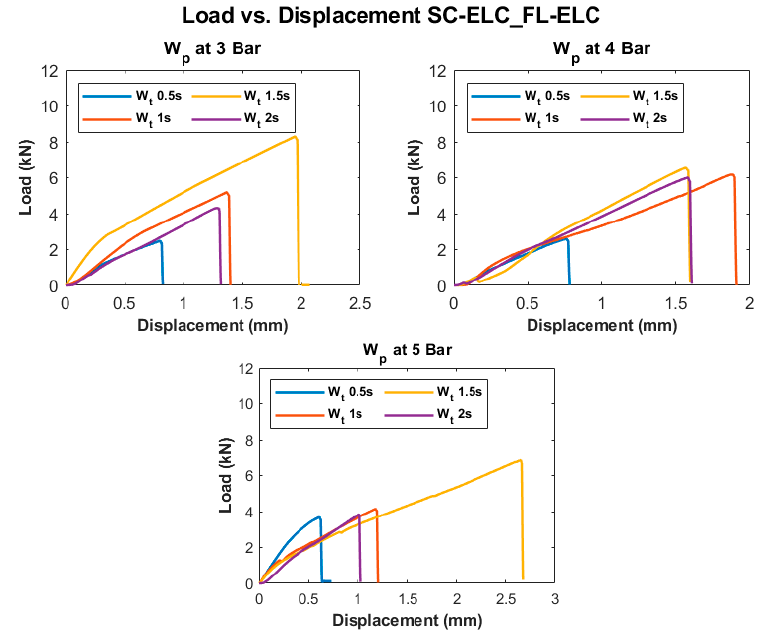
Figure 11. Load vs. Displacement curves of SC-ELC_FL-ELC configuration at different welding conditions. Displacement and weld strength changes can both be explained, as, with the increase in weld time, the amount of weld energy at the interface increases as at a specific pressure, the weld time is directly proportional to the weld energy that is transferred to the adherend [72]. Higher energy at the interface helps in the melting and flowability characteristics of the energy directors and the